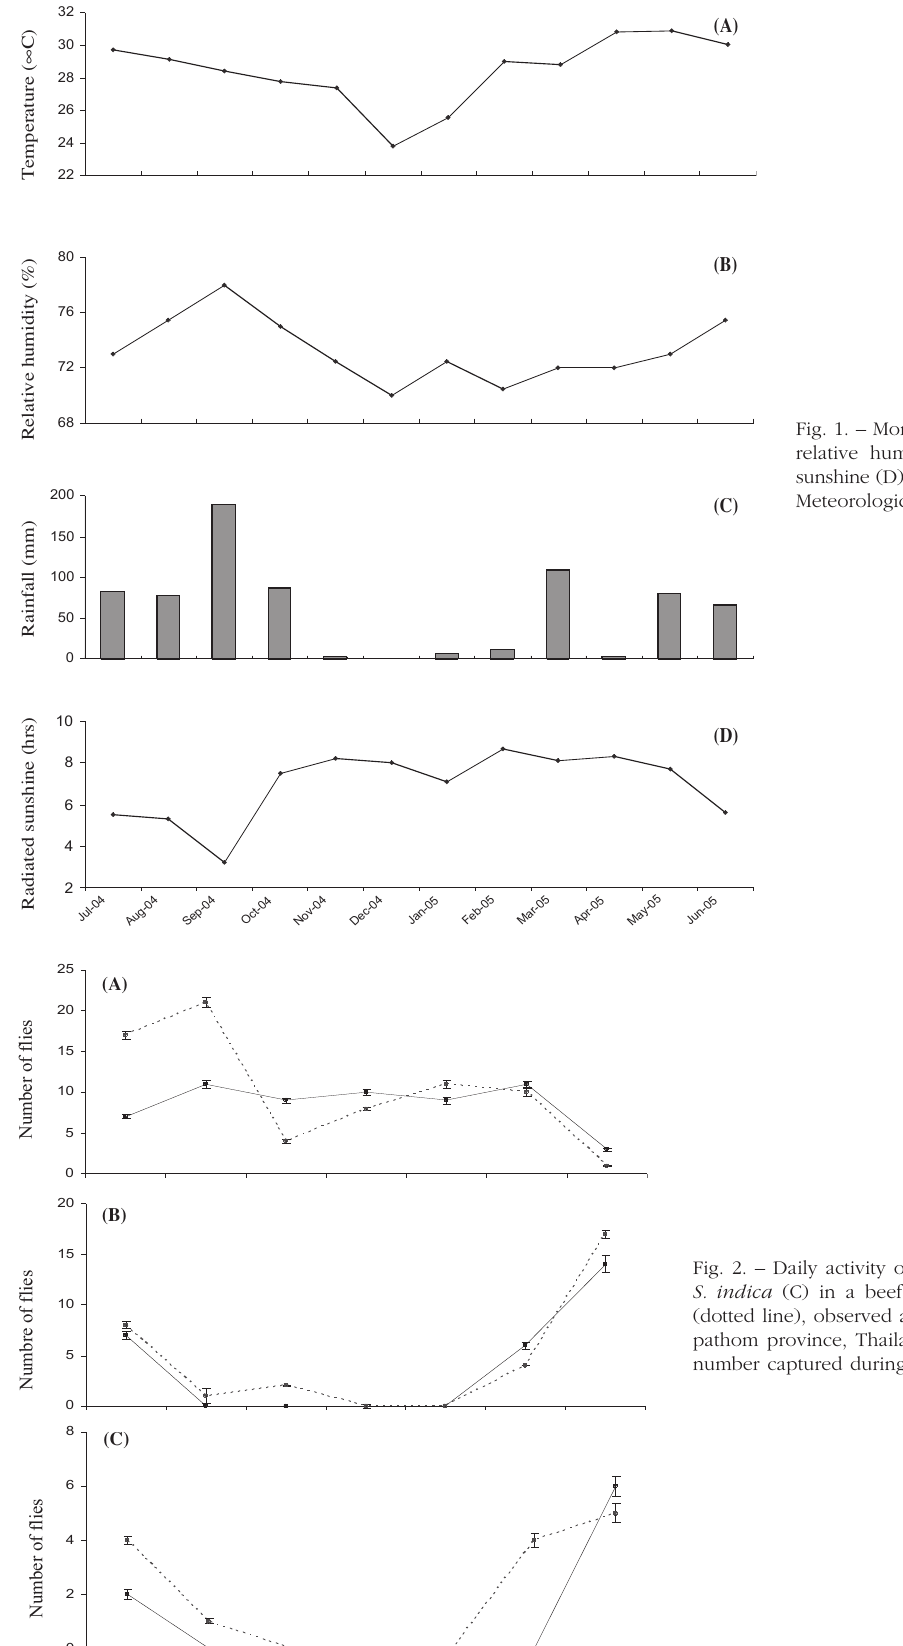
Fig. 2. – Daily activity of S. calcitrans (A), S. sitiens (B) and S. indica (C) in a beef farm (plain line) and a dairy farm (dotted line), observed at Kamphaengsaen Campus, Nakorn- pathom province, Thailand. The number of flies is the total number captured during the survey